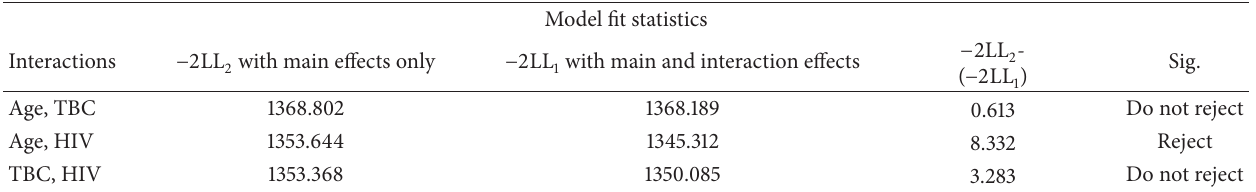
Table 6: Result of partial likelihood ratio test for the contribution of the interaction effect.